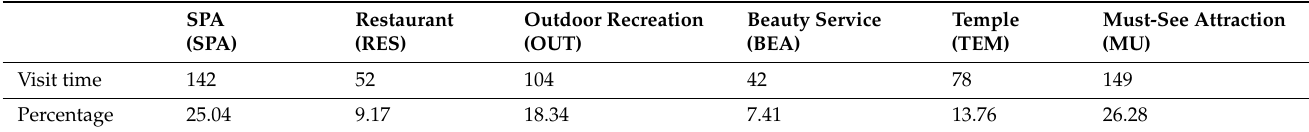
Table 9. Percentage of time that groups of attractions and destinations are visited .